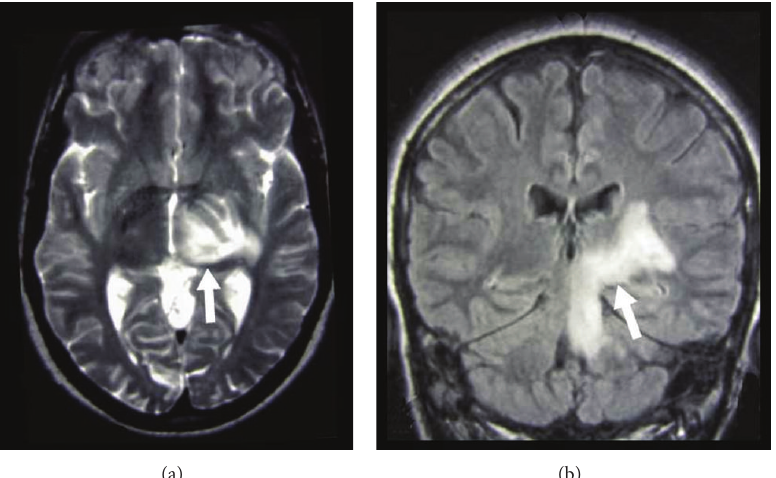
Figure 15: A patient with neuro-Behcet showing a left-sided hyperintense lesion on axial T2-weighted (a) and coronal FLAIR (b) imaging involving the cerebellum, the midbrain, and the inferior part of the thalamus (arrows), the internal capsule, and the putamen.